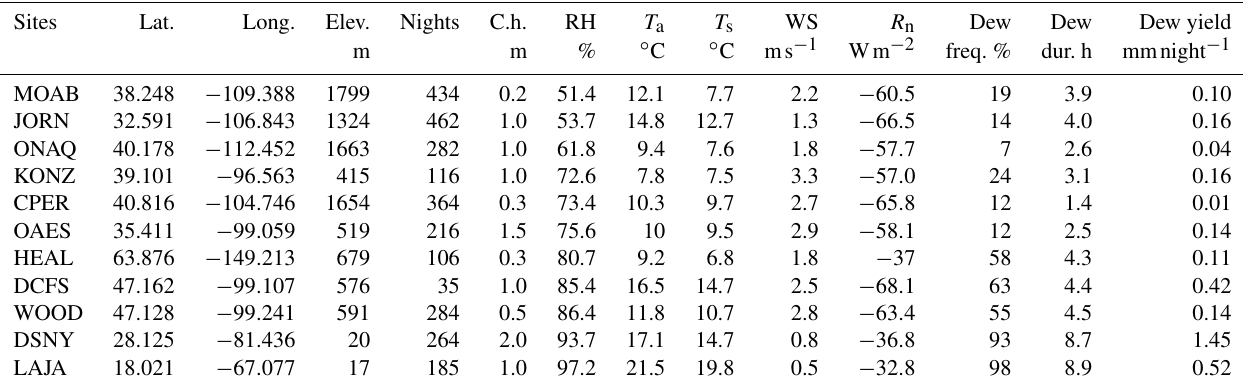
Figure 1. (a) Vertical position of the sensors for each site (ordered with an increasing canopy height). (b) Elevation and locality of the sites in the USA. Table 1. Summary of the results for the grassland sites ordered with an increasing RH. Dew frequency, duration, yield and meteorological parameters (averaged from 23:00 to 05:00 the next day) have been calculated at the top of the canopy, except RH (close to the ground). C.h. stands for canopy height, and elev. stands for